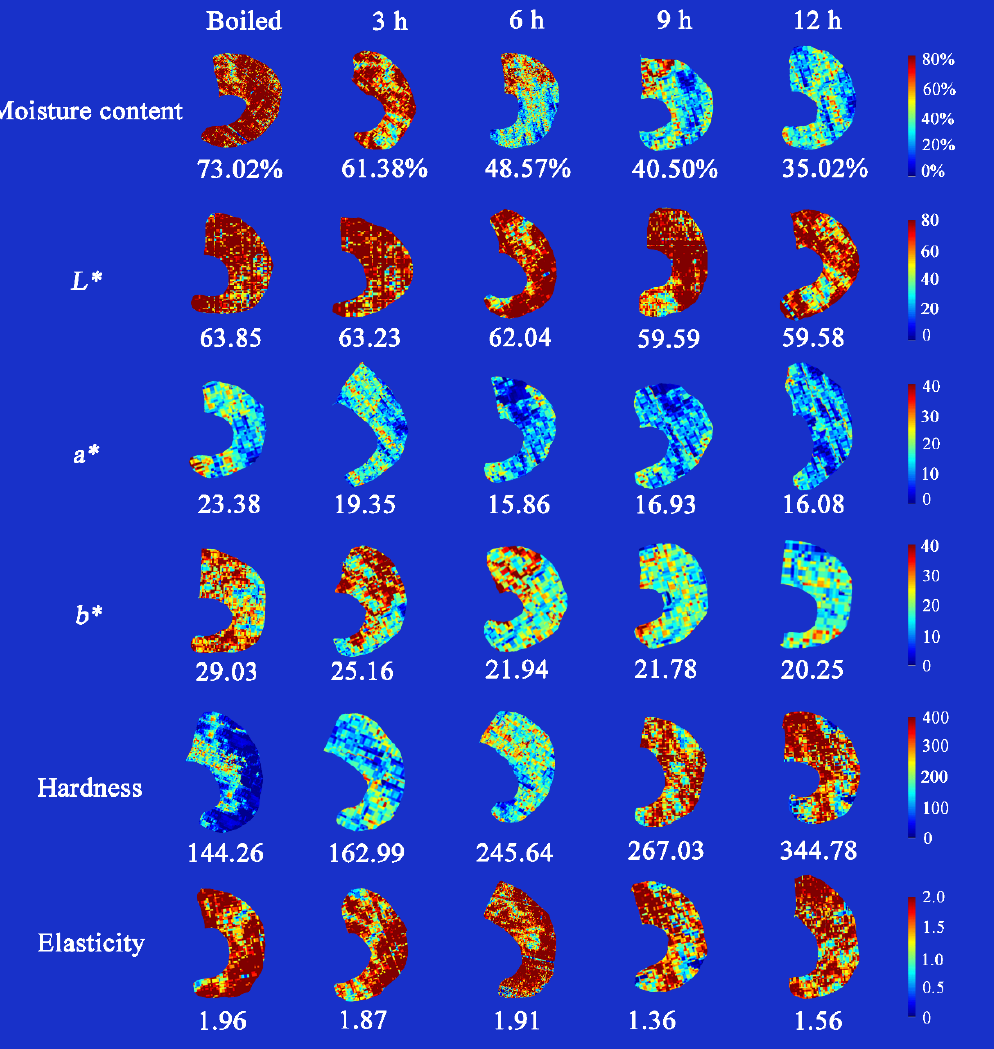
Figure 10. Moisture content, color ( L *, a *, and b *) and texture (hardness, and elasticity) visualization map of shrimp at different drying times (boiled, 3, 6, 9 and 12 h).